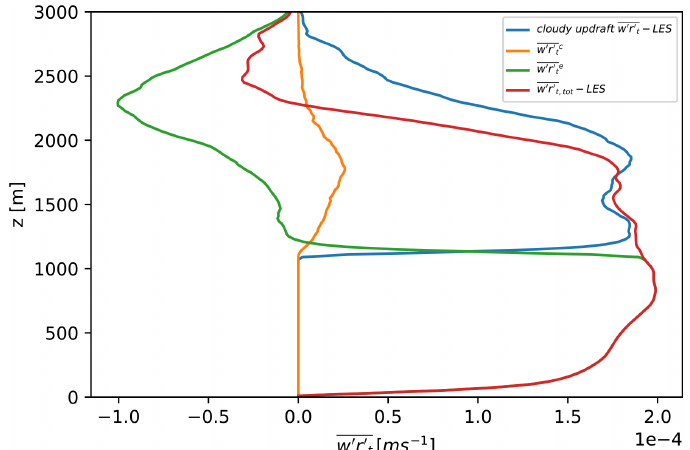
Figure C1. Decomposition of the turbulent fluxes for the ARM case, ninth simulation hour. Plotted are LES cloudy updraft flux (blue), small-scale subplume transport (orange), small-scale environmental transport (green), and total transport